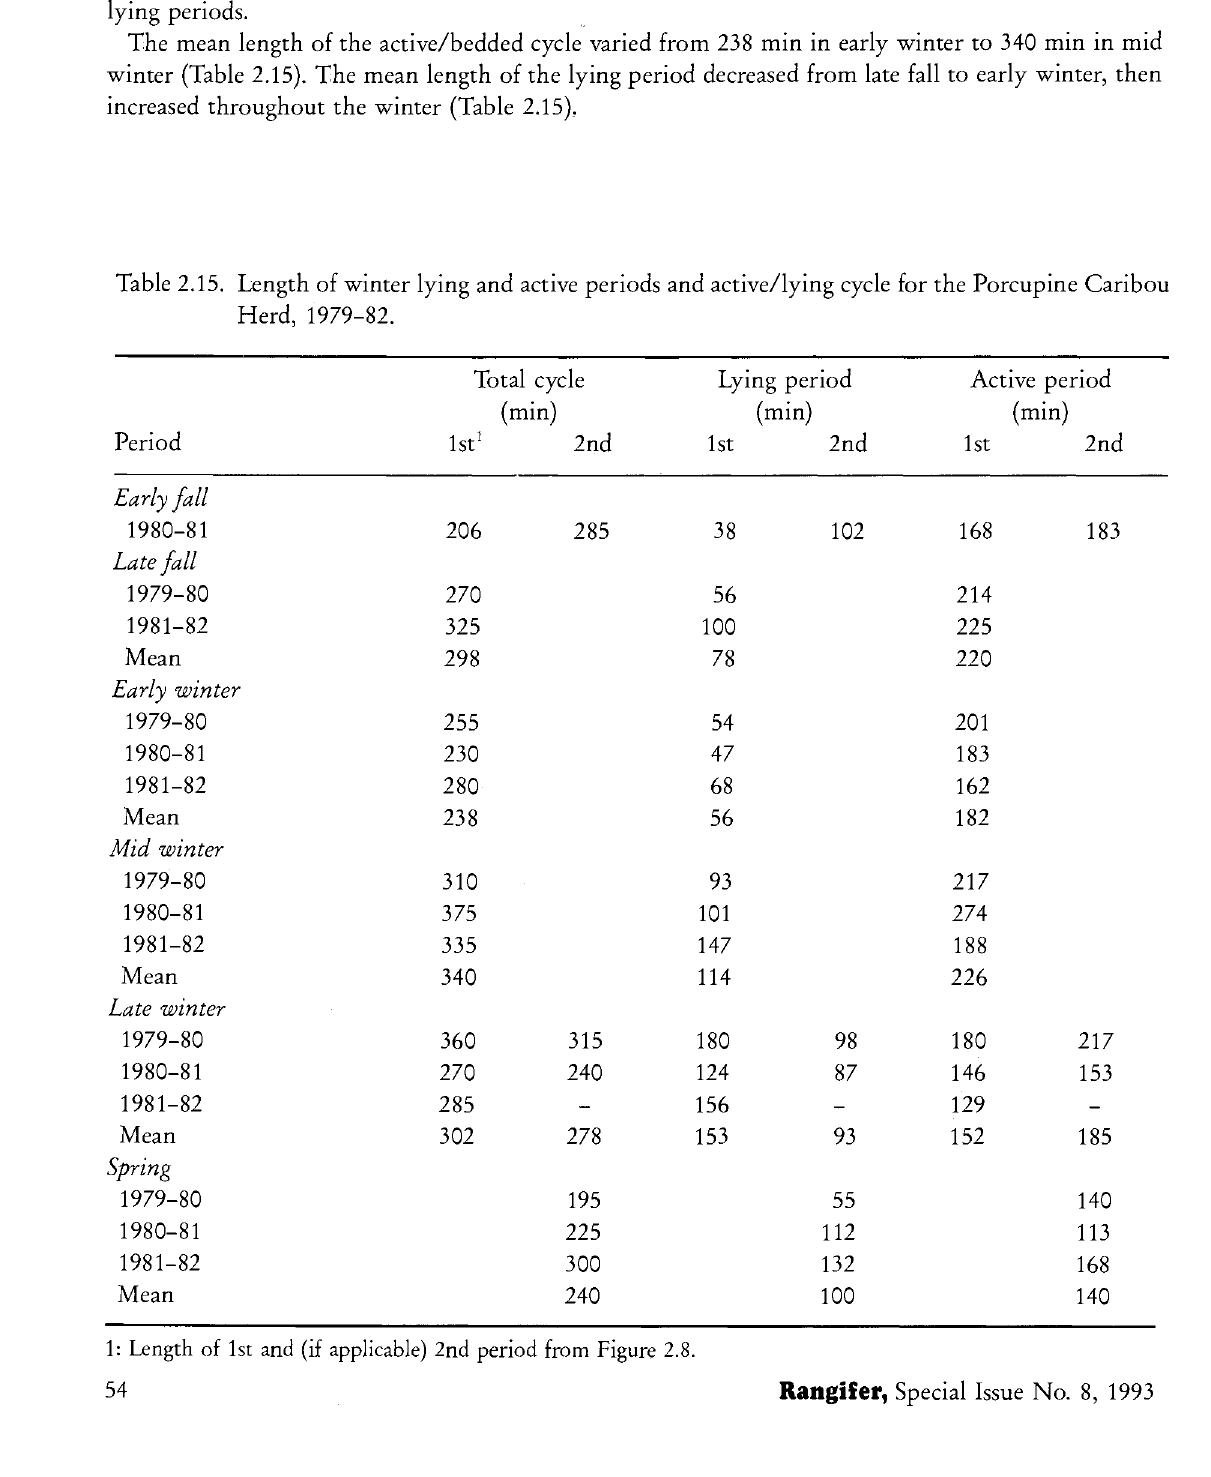
Table 2.15. Length of winter lying and active periods and active/lying cycle for the Porcupine Caribou Herd,